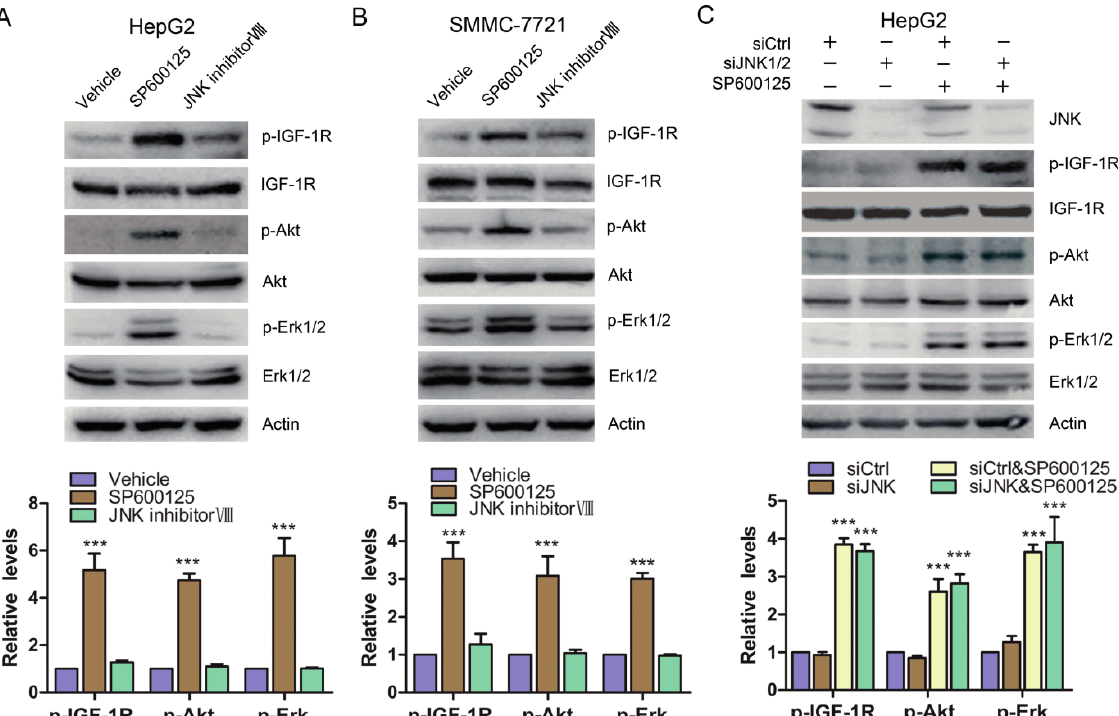
Figure 3. Effects of SP600125 on IGF-1R signaling pathway is independent of JNK. ( A , B ) HepG2 and SMMC-7721 cells were treated with 15 µM SP600125 or 20 µM JNK inhibitor VIII for 48 h. Total protein extracts were harvested and subjected to western blot analysis of phosphorylated IGF-1R, Akt, Erk1/2 and total IGF-1R, Akt, Erk1/2; and ( C ) HepG2 cells were transfected with siCtrl or siRNA against JNK for 24 h, followed by treatment with or without 15 µM SP600125 for 48 h. Total protein extracts were harvested and subjected to western blot analysis of phosphorylated IGF-1R, Akt, Erk1/2 and total IGF-1R, Akt, Erk1/2. β -Actin was detected as loading control. The blots were subjected to densitometric analysis and relative quantification. Levels in control samples were set as 1. A representative of three experiments was shown. *** , p < 0.001, compared with other